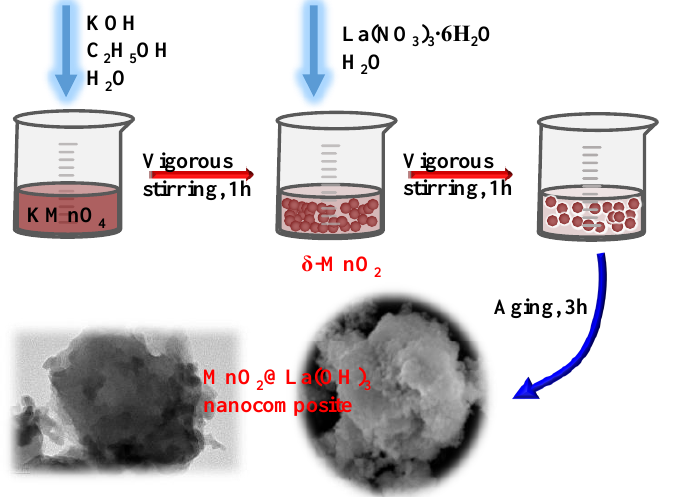
Figure 1. Schematic illustration of the preparation of core – shell structured MnO 2 @La(OH) 3 nano- composite.